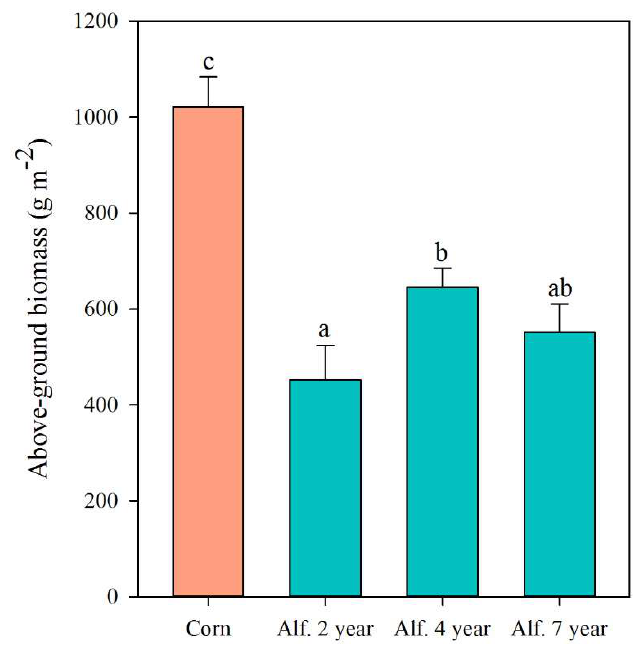
Figure 5. Above-ground biomass in the cornfield and in the two-, four- and seven-year-old alfalfa pastures. Different lowercase letters indicate statistically significant differences at the 0.05 level.